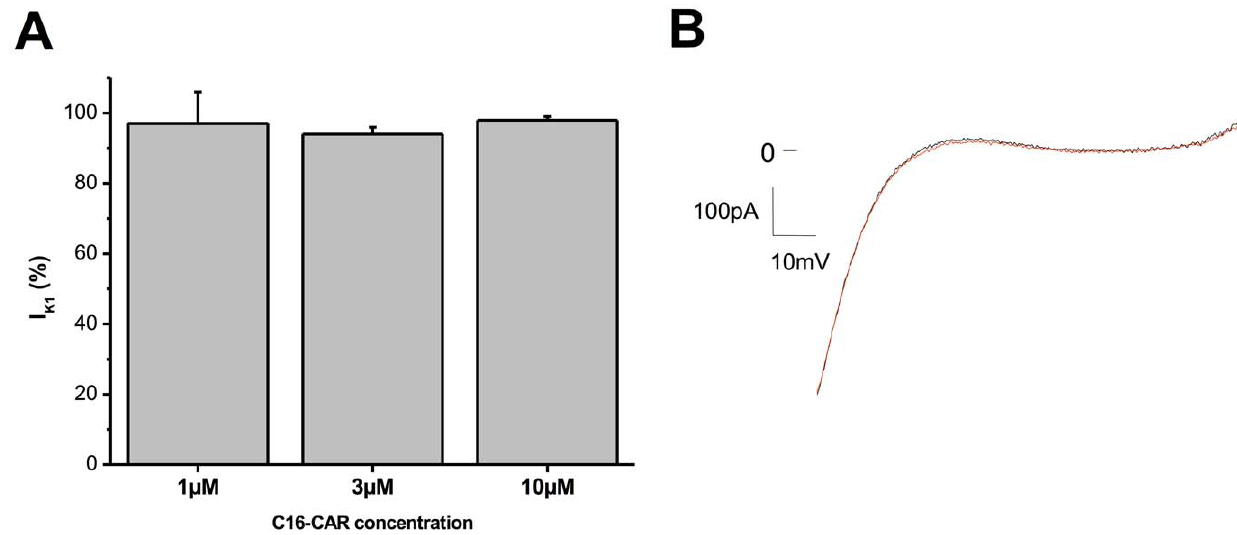
Figure 6. Effect of C16-CAR on I K1 . A , mean current measured at 2 120 mV and normalized to the current in PSS (n=7 cells). B , typical example of I K1 elicited by a ramp of voltage between 2 120 and + 40 mV, with (red) or without (black) 10 m M C16-CAR.